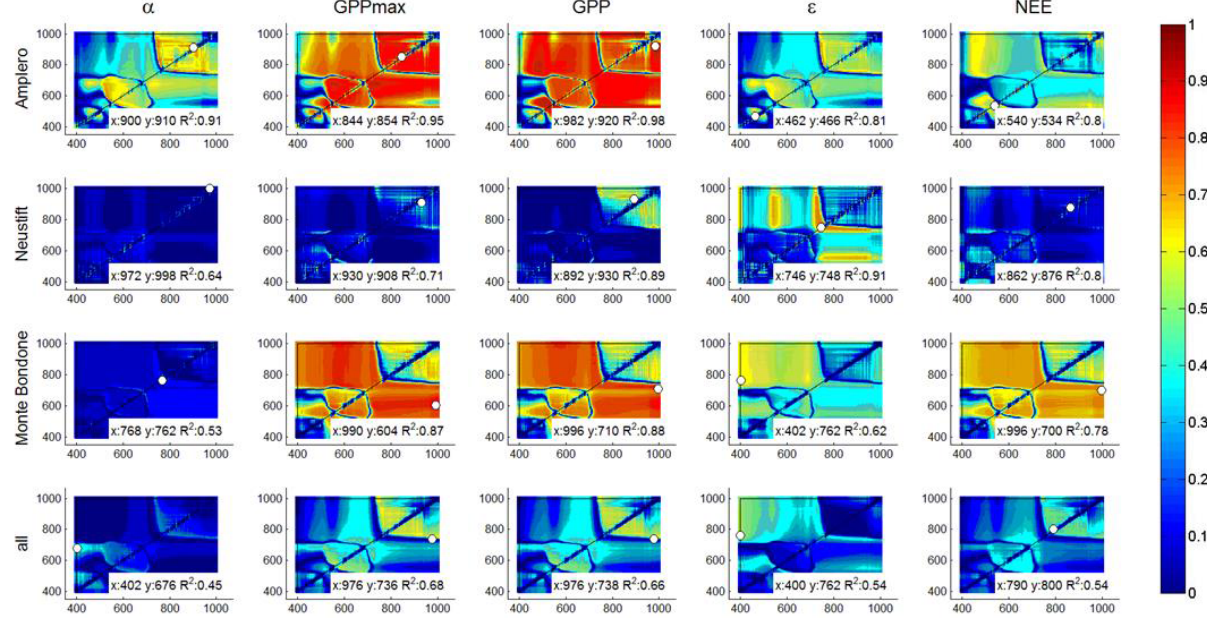
Figure 4. Correlograms of R 2 values for α , GPP max , midday averaged GPP, ε and NEE, on the one hand, and SR-type indices for Amplero, Neustift, Monte Bondone (both study years pooled) and all sites pooled on the other. The white dots indicate the position of paired band combinations corresponding to the maximum R 2 .